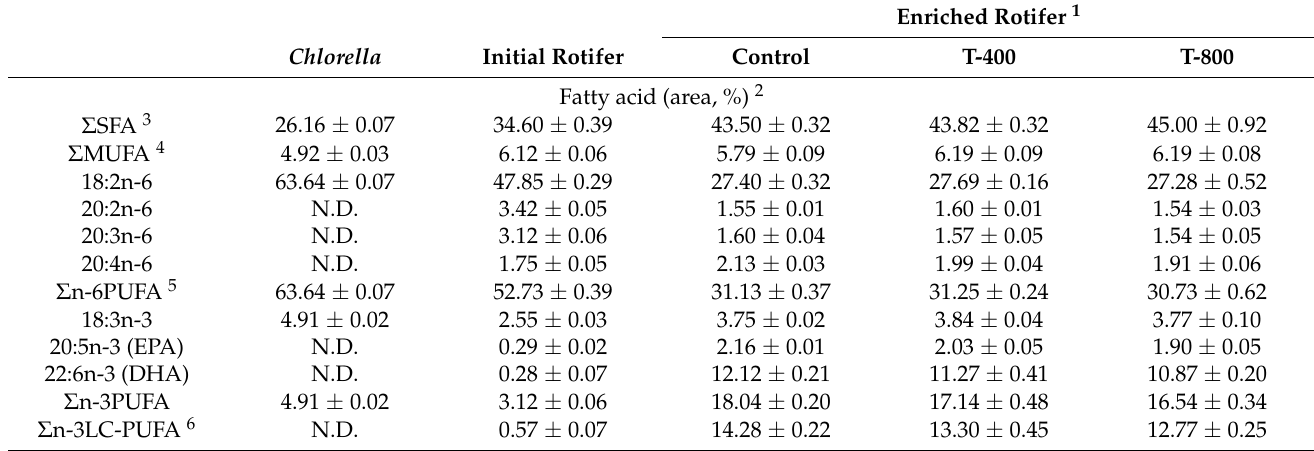
Table 2. Fatty acid composition (% of total fatty acids) of rotifers.